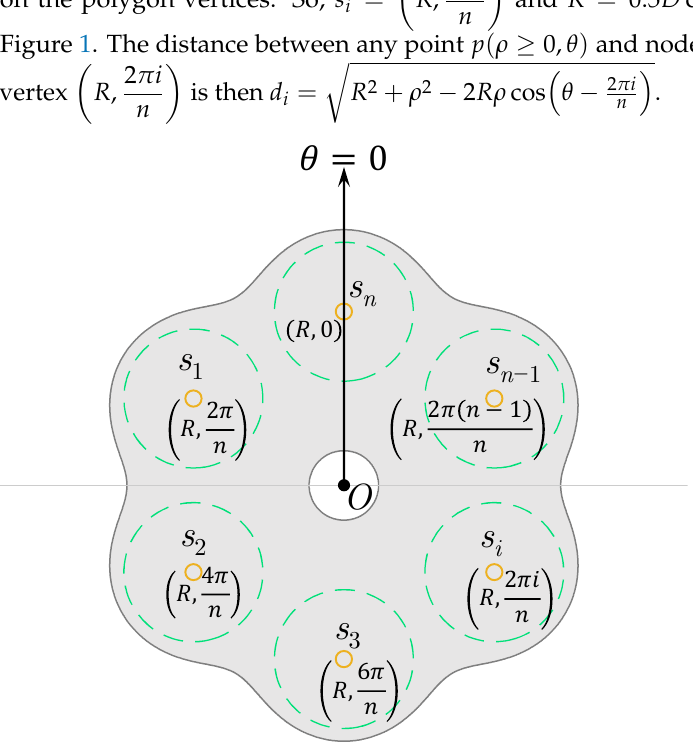
Figure 1. Illustration of an n -node team forming an n -sided regular polygon, with the nodes being located on its vertices. The shaded gray region is the effectively covered region (an example) by the team, while the n dashed circles show individual effective coverages with radius ¯ r . The polar coordinate system is established in such a way where the pole is located at the circumcenter of the polygon, and the polar axis points towards s n